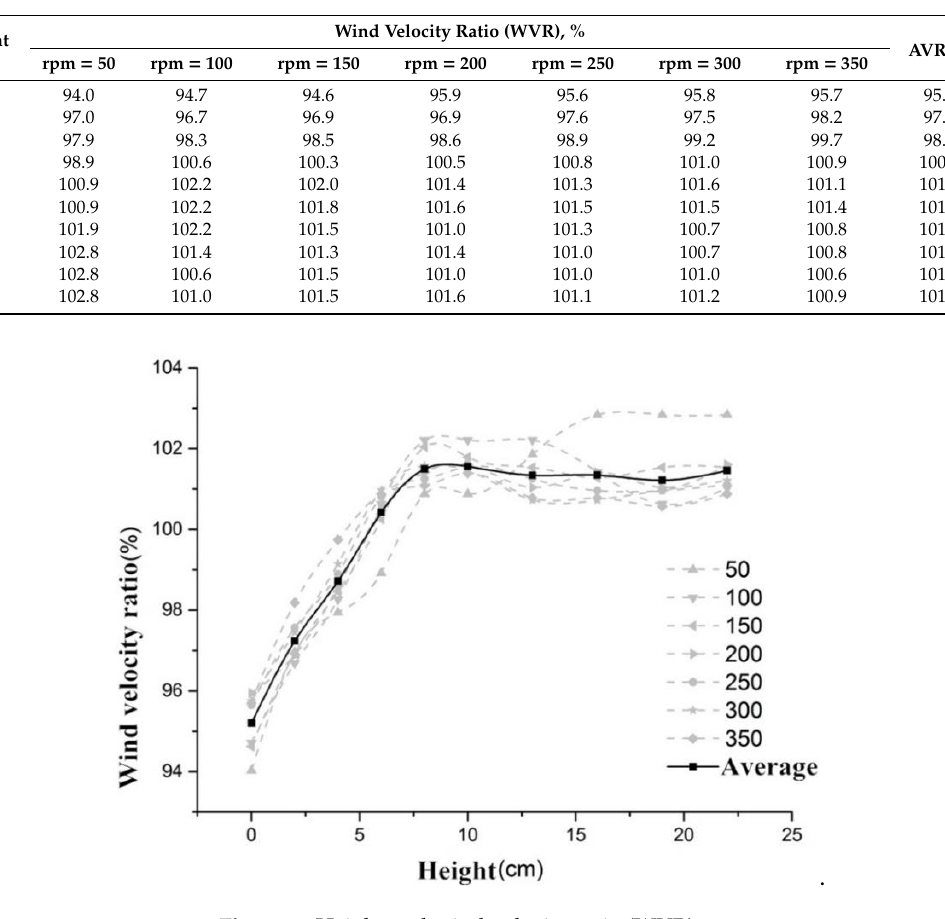
Figure 2. Height and wind velocity ratio (WVR).